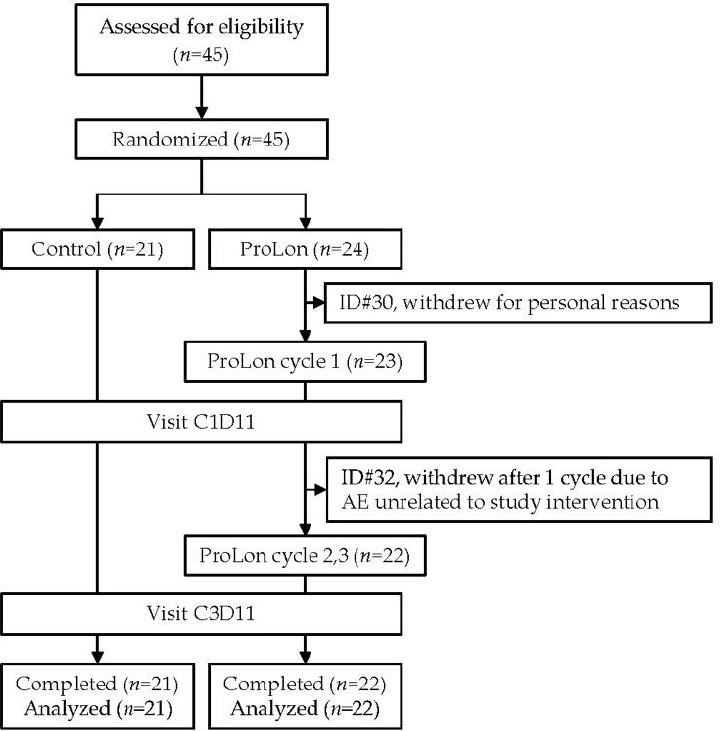
Figure 1. CONSORT (Consolidated Standards of Reporting Trials) flow diagram. C1D11, cycle 1, day 11; C3D11, cycle 3, day 11. 11; C3D11, cycle 3, day